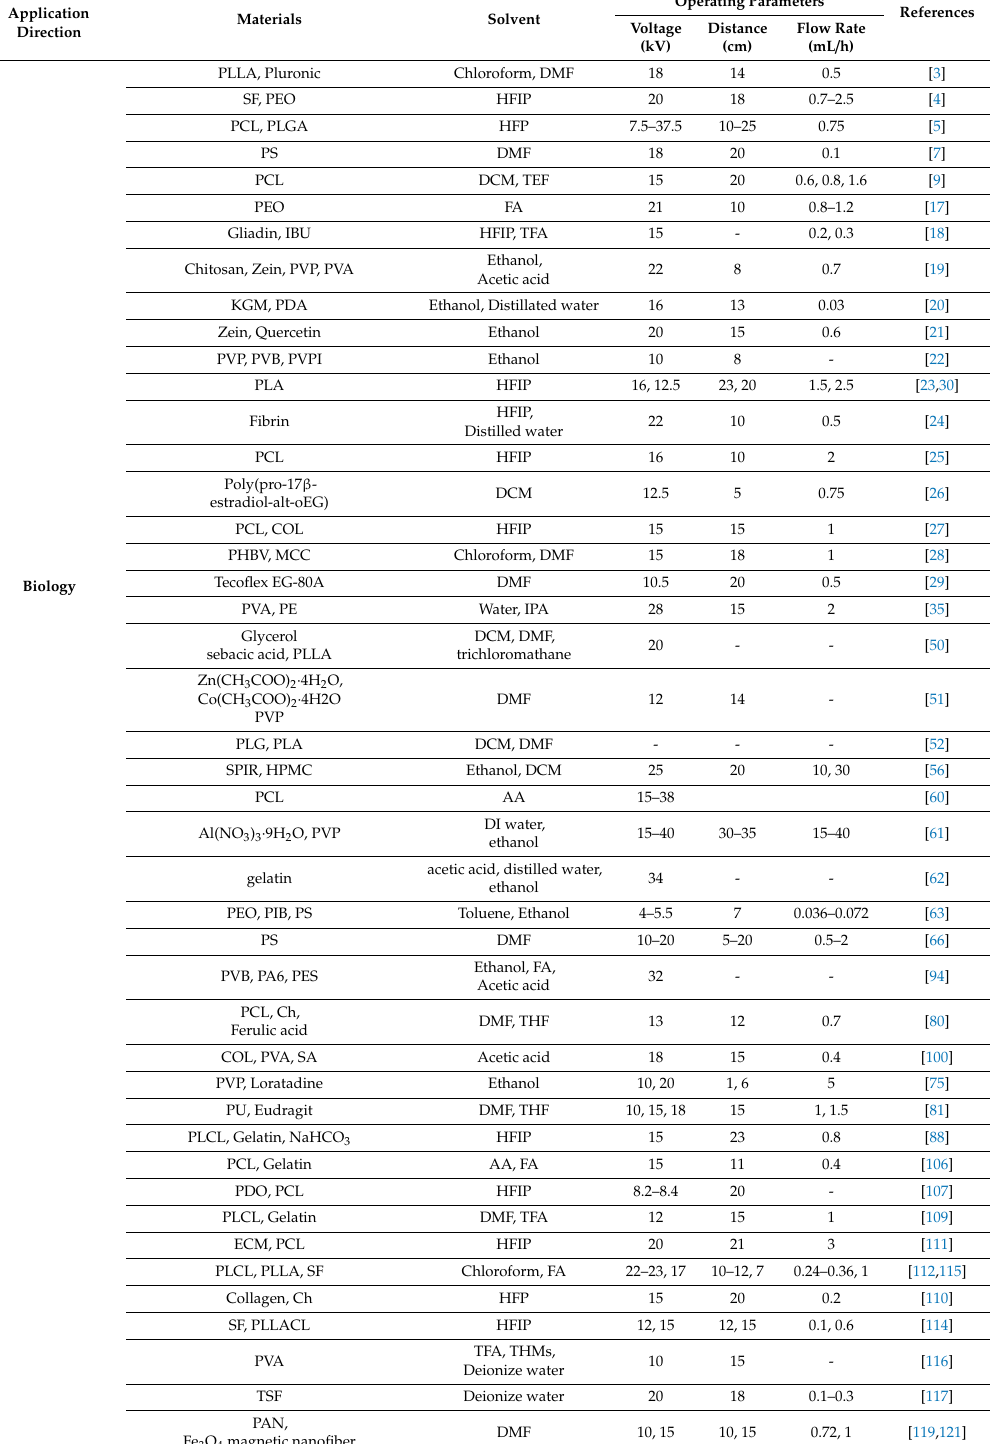
Table 2. Applications of electrospinning technology in biology, environmental protection, ecofriendly energy, and packaging